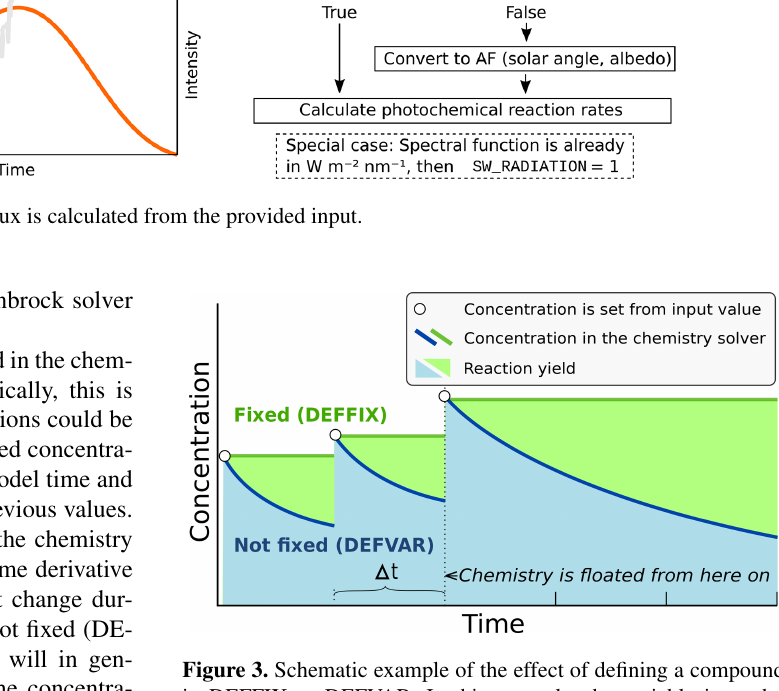
Figure 3. Schematic example of the effect of defining a compound in DEFFIX or DEFVAR. In this example, the variable is set by the user (in the GUI, this is done in the tab “time-dependent in- put”). The solid lines show the concentrations inside the chemistry solver for a compound which is fixed (green curve) and not fixed (blue curve). The circular symbols show the set concentration in each time step. The shaded areas represent the proportional im- pact of DEFFIX and DEFVAR on the concentrations of the reaction products of the compound. Depending on the model time step (cid:49)t , the differences can be substantial and illustrate why the precursors should be set fixed unless the chemistry needs to be